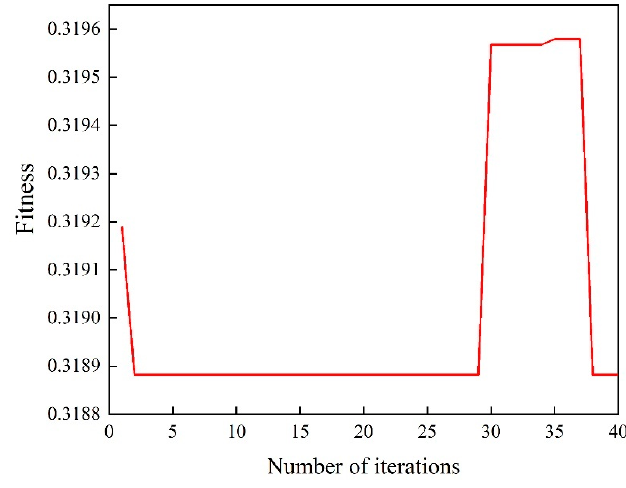
Figure 5. Optimization curve of the function fitness of the model of K c .